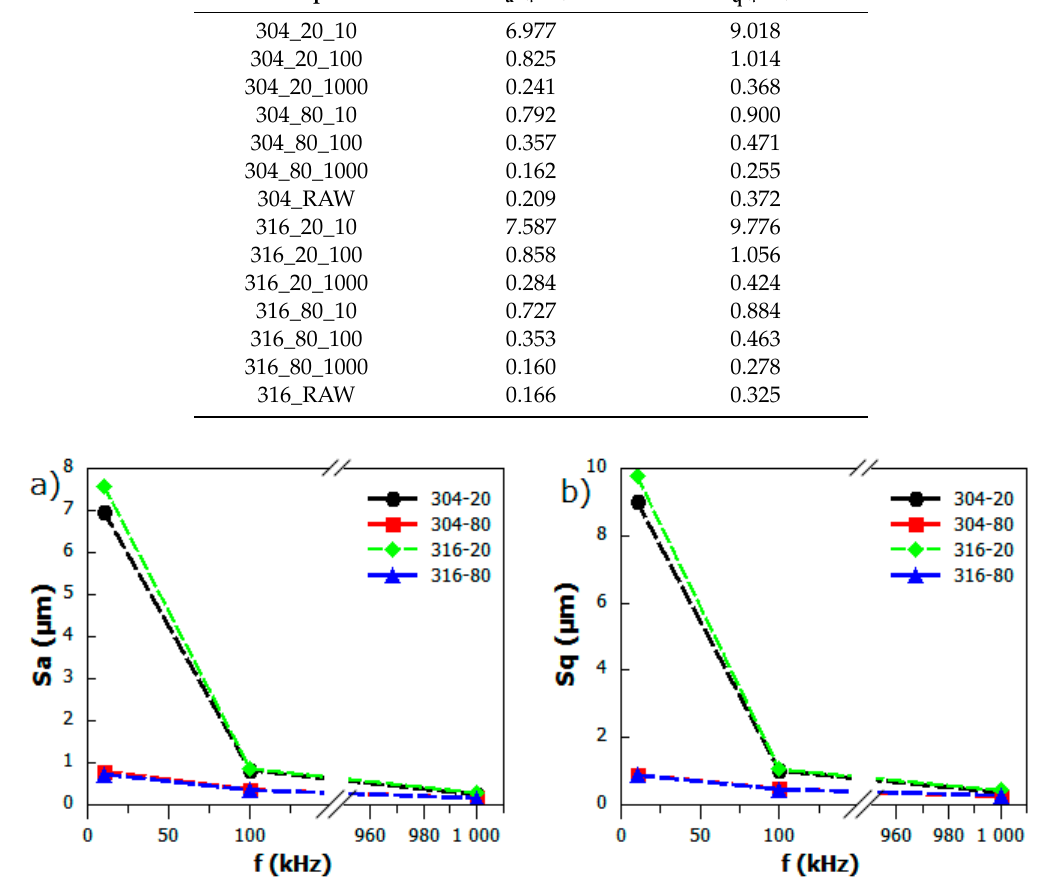
Figure 4. The ( a ) S a and ( b ) S q 3D roughness parameters versus pulse repetition rate ( f ) for laser-treated AISI 304 and 316 sample series. Table 3. The 3D surface roughness parameters S a and S q . The 304_RAW and 316_RAW samples represent the unmodified plates.